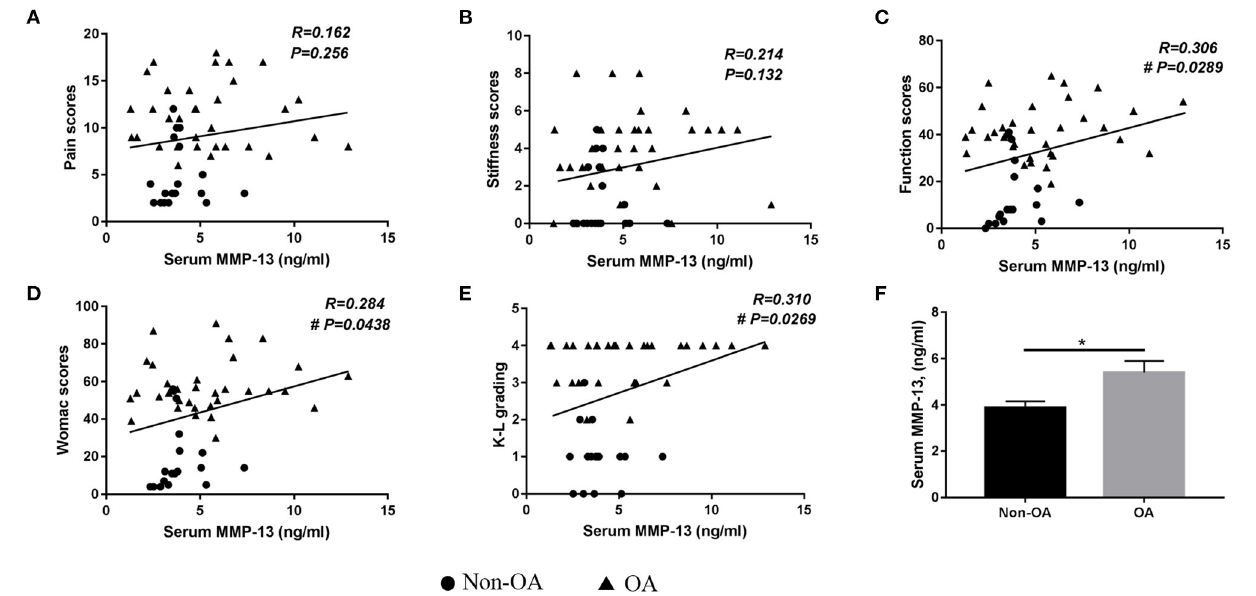
FIGURE 3 | Analysis of factors relating serum MMP-13 with osteoarthritic symptoms and radiographic severity. Correlations between plasma MMP-13 levels and (A) pain scores, (B) stiffness scores, (C) function scores, (D) total Western Ontario and McMaster Universities Osteoarthritis Index scores, (E) Kellgren–Lawrence grading in all patients, (F) serum MMP-13 levels in patients with and without OA. Value = mean ± standard error of the mean. OA, osteoarthritis. * p < 0.05; # indicates the difference was statistically significant ( p < 0.05).